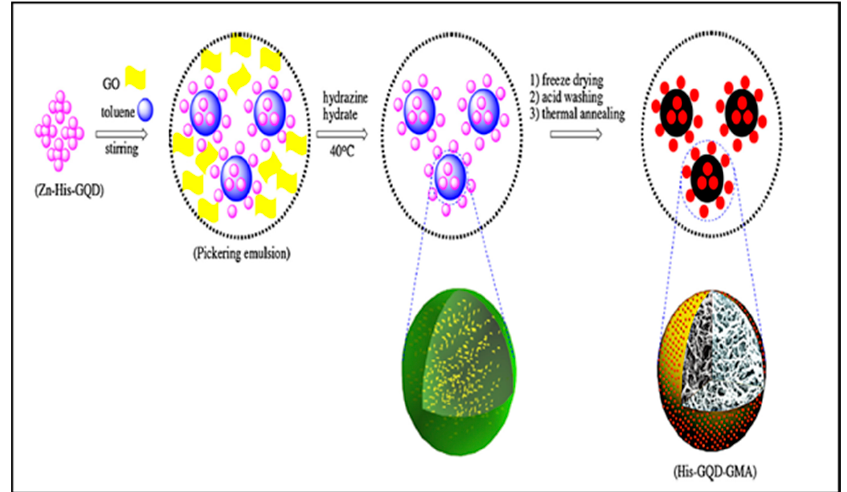
Figure 9. Preparation of the His-GQDs-GMA nanocomposite (Reproduced from [97], copyright Elsevier, 2017).